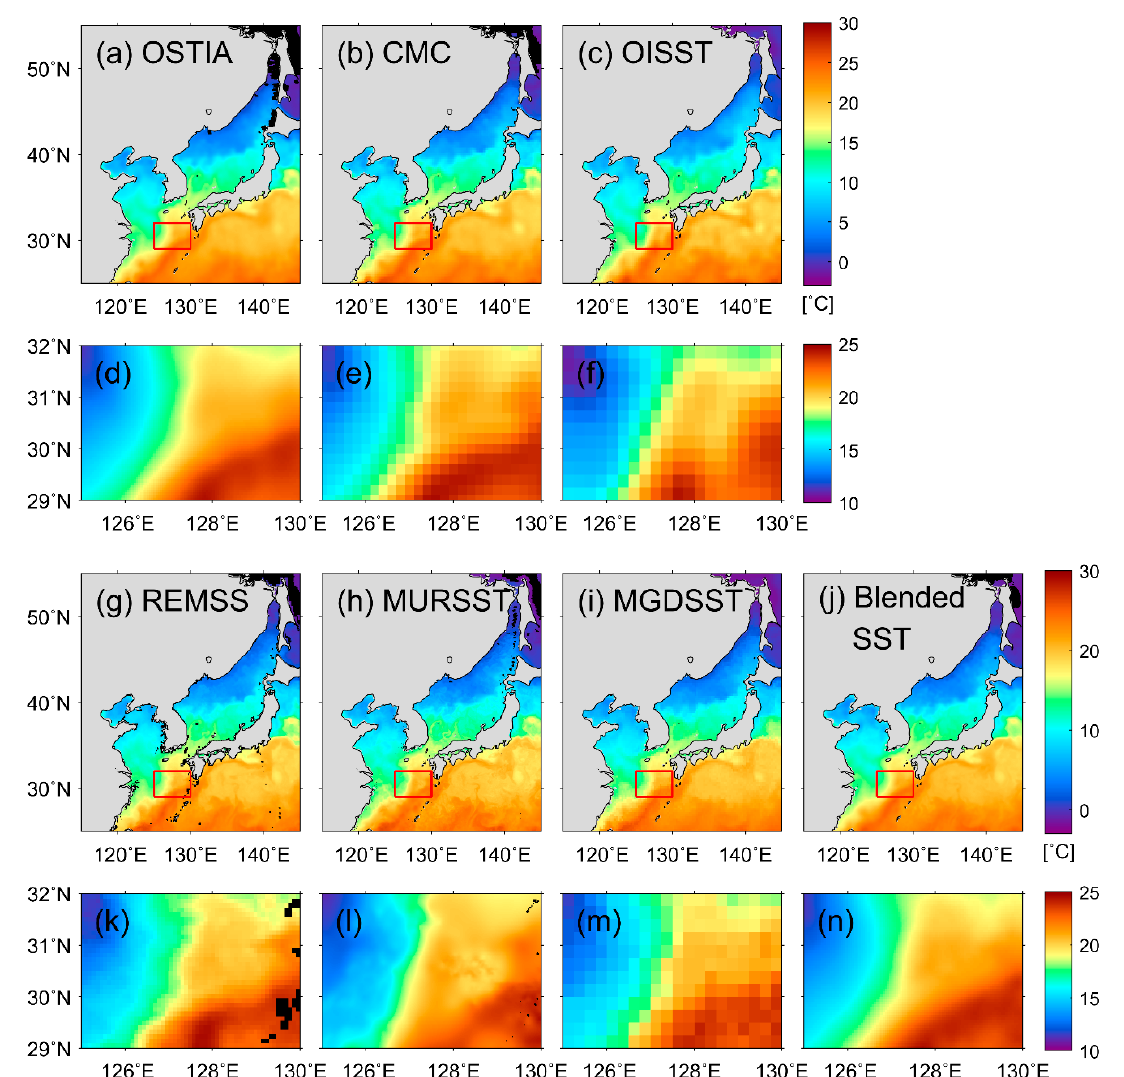
Figure 2. Spatial distribution of sea surface temperatures—( a ) OSTIA; ( b ) CMC analysis; ( c ) OISST; ( d – f ) enlarged SST data for the red box in ( a – c ); ( g ) REMSS analysis; ( h ) MURSST; ( i ) MGDSST; ( j ) Blended SST; and ( k – n ) enlarged SST data for the red box in ( g – j ).